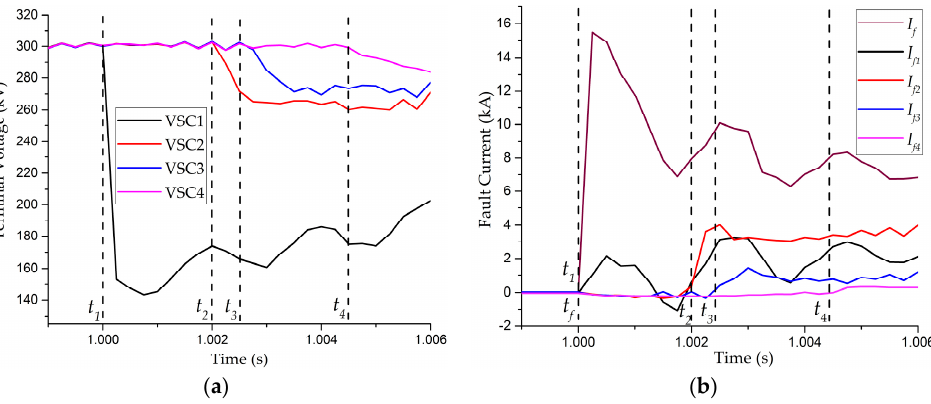
Figure 8. Propagation time delay in MTDC network in case of fault near VSC1. ( a ) Voltage response, ( b ) current response.